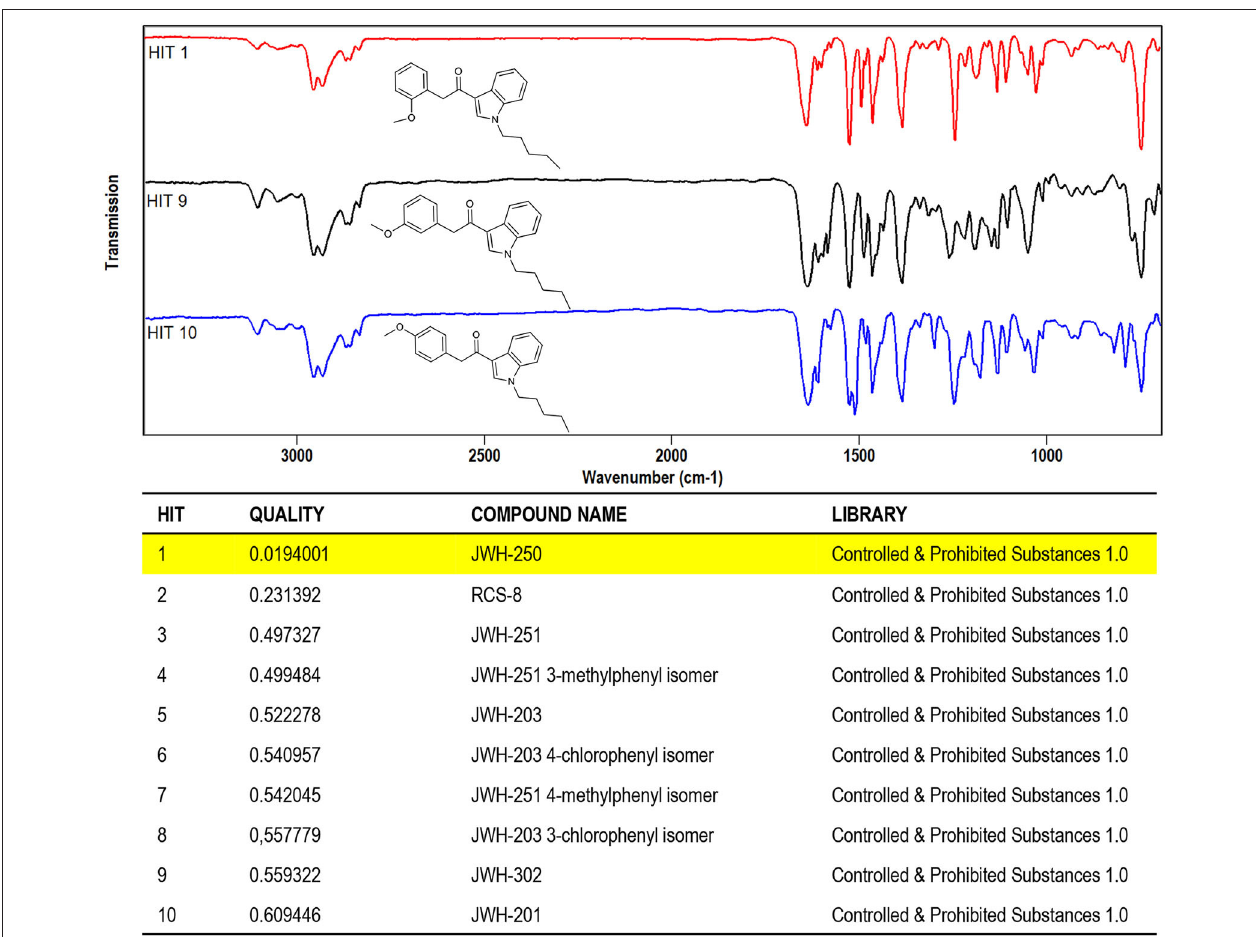
FIGURE 7 | Software window showing the library search results obtained for JWH-250 IR spectral data. (Top) IR spectra of JWH-250 and its regioisomers JWH-302, JWH-201 (Hits 9, 10). (Bottom) QMF obtained for JWH-250 against correct and incorrect matches. Quality is expressed in 0–1 units (with 0 representing the maximum value for similarity or quality